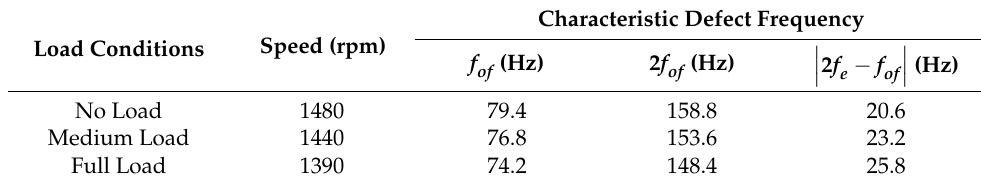
Table 1. Bearing outer race defect